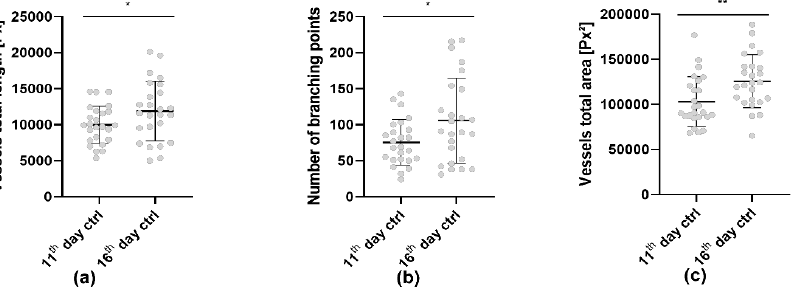
Figure 3. Increase in perfusion detected by the CAM assay application v3.0.0 of 25 CAMs grafted with AS-M cell line tumors (n = 25). ( a ) Total vessel length detected by the CAM assay application. ( b ) Branching points detected by the CAM assay application. ( c ) Total area of all vessels detected by the CAM assay application. All three data sets were analyzed using one-way ANOVA with Tukey´s multiple comparisons test (* p < 0.05, ** p < 0.01).